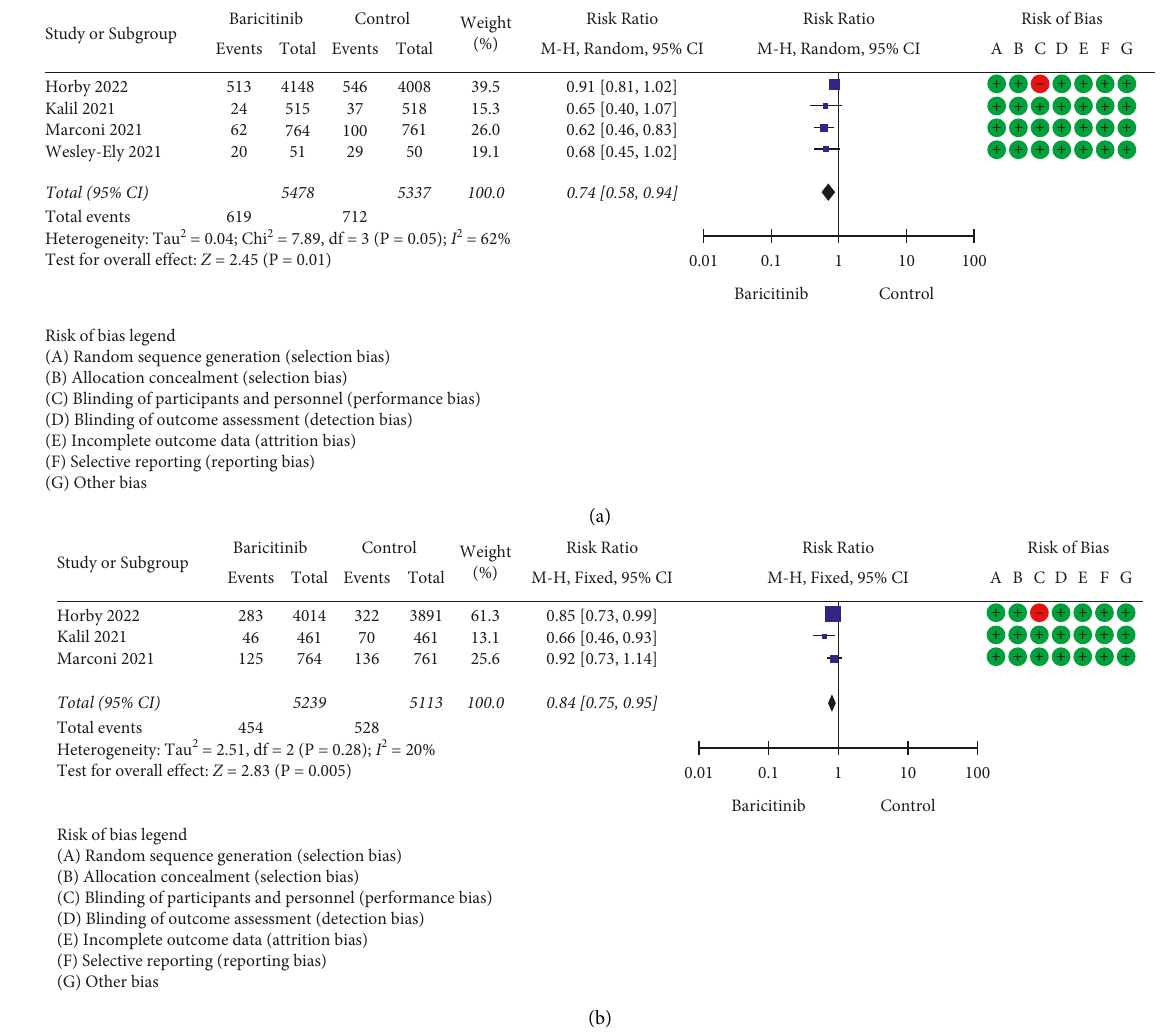
Figure 2: (a) The effect of baricitinib on mortality. (b) The effect of baricitinib on disease progression in COVID-19 patients. Marconi et al. [7] were contacted for additional information. The additional information was supplied by Eli Lilly, the sponsor company. The letter is supplied as supplementary file